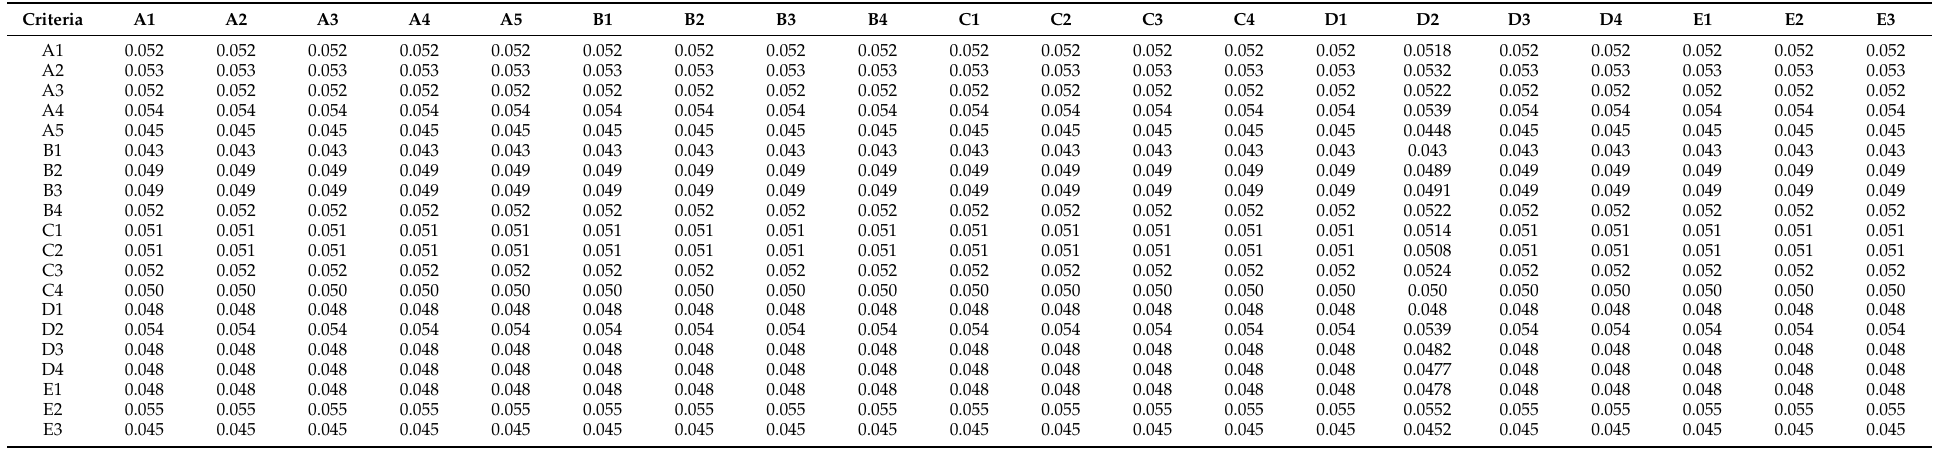
Table A3. Criteria limit super